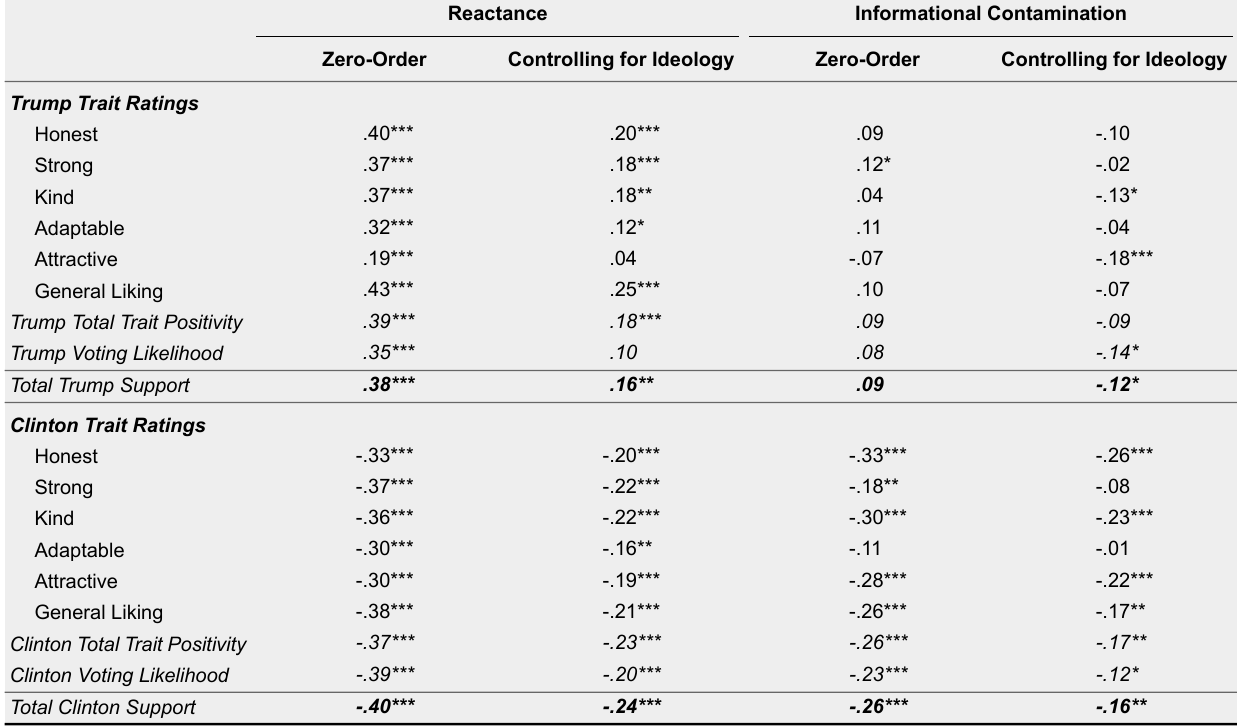
Chronic Restrictive Communication Concern Predicting Support for Trump and Clinton